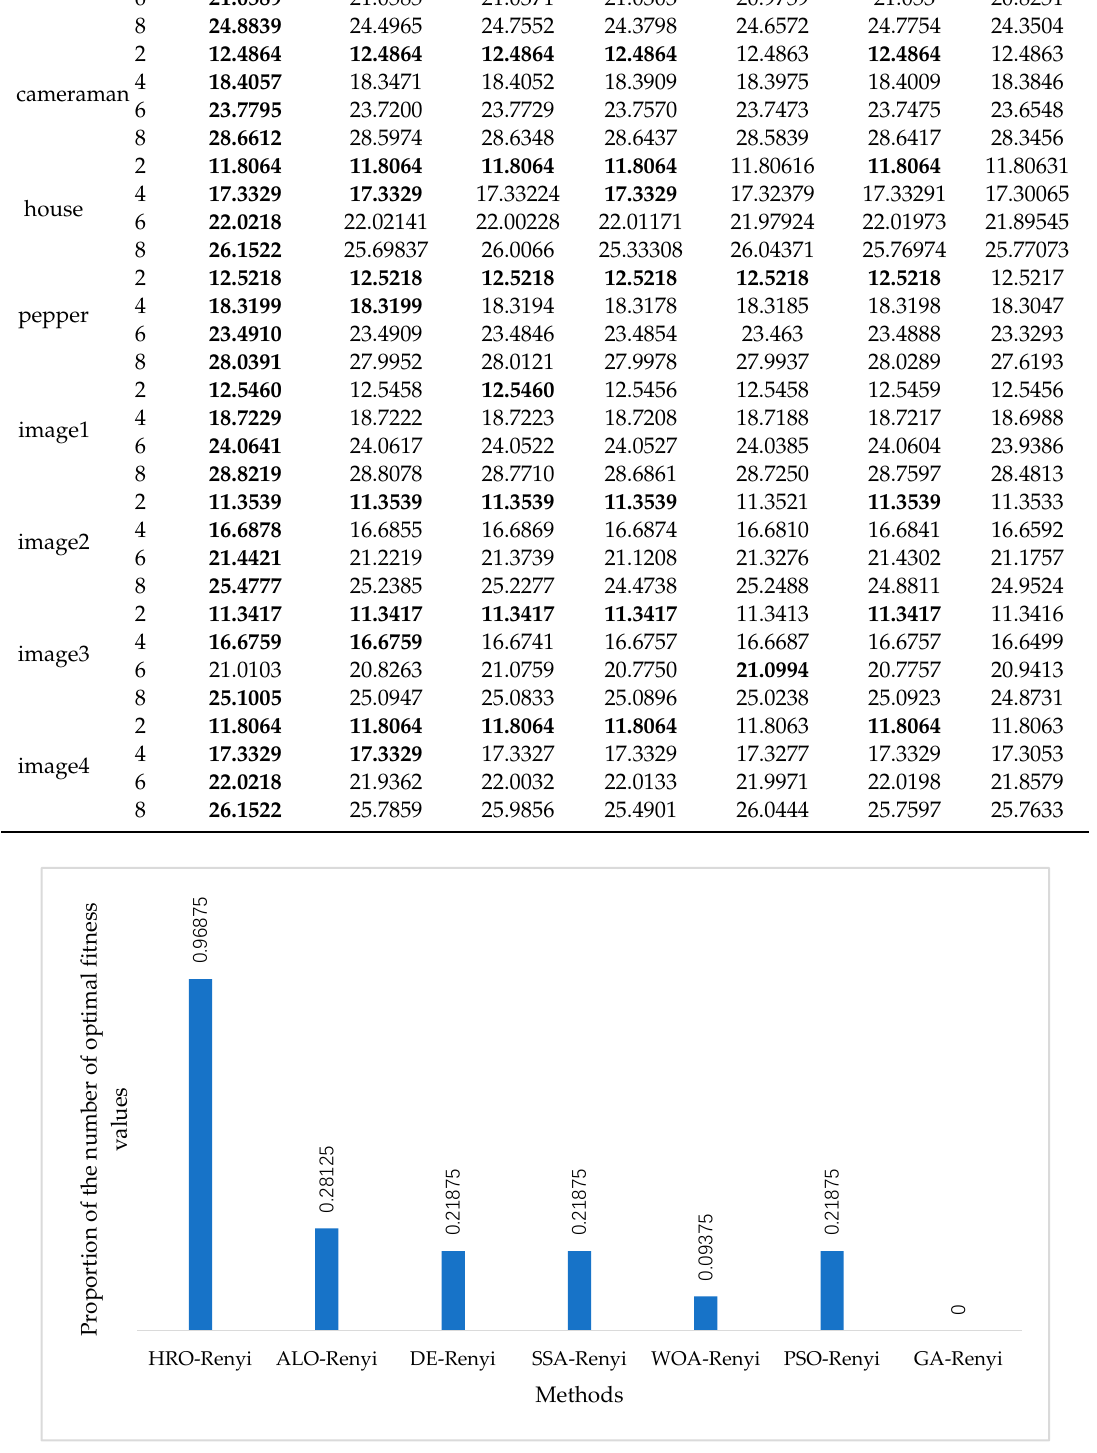
Figure 4. The proportion of optimal average fitness value obtained by each method in the total number of experiments.